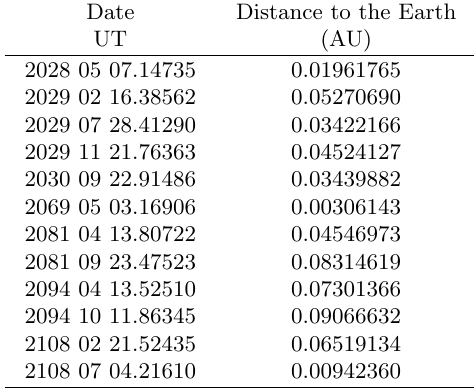
Table 4. Asteroid 2000 SG344. Close approaches of the nominal orbit to the Earth until